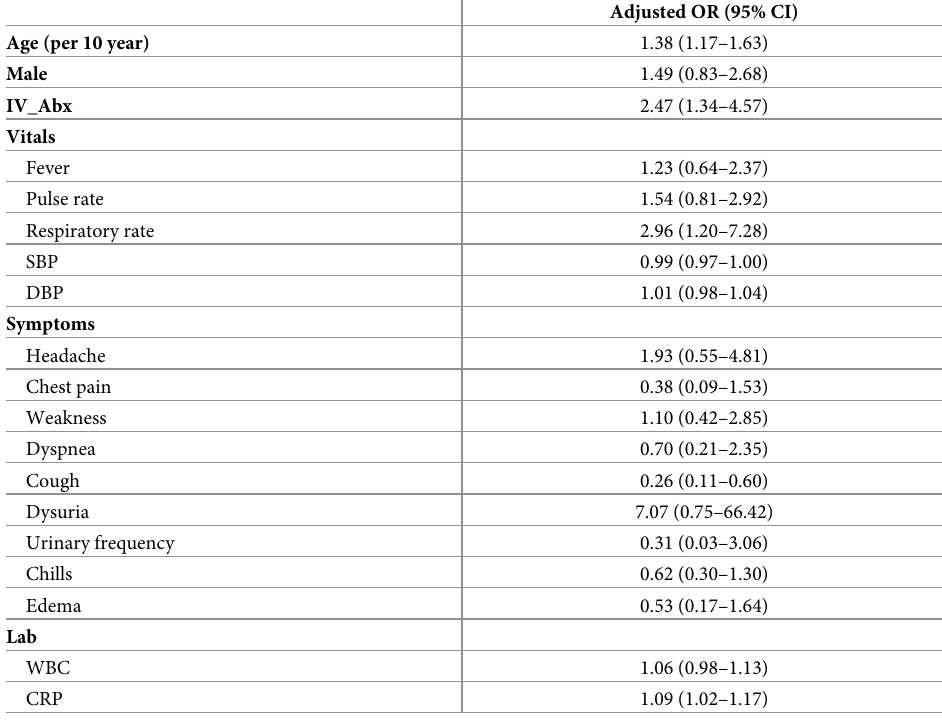
Table 3. The factors on hospital or ICU admission after ED return visits in the infection